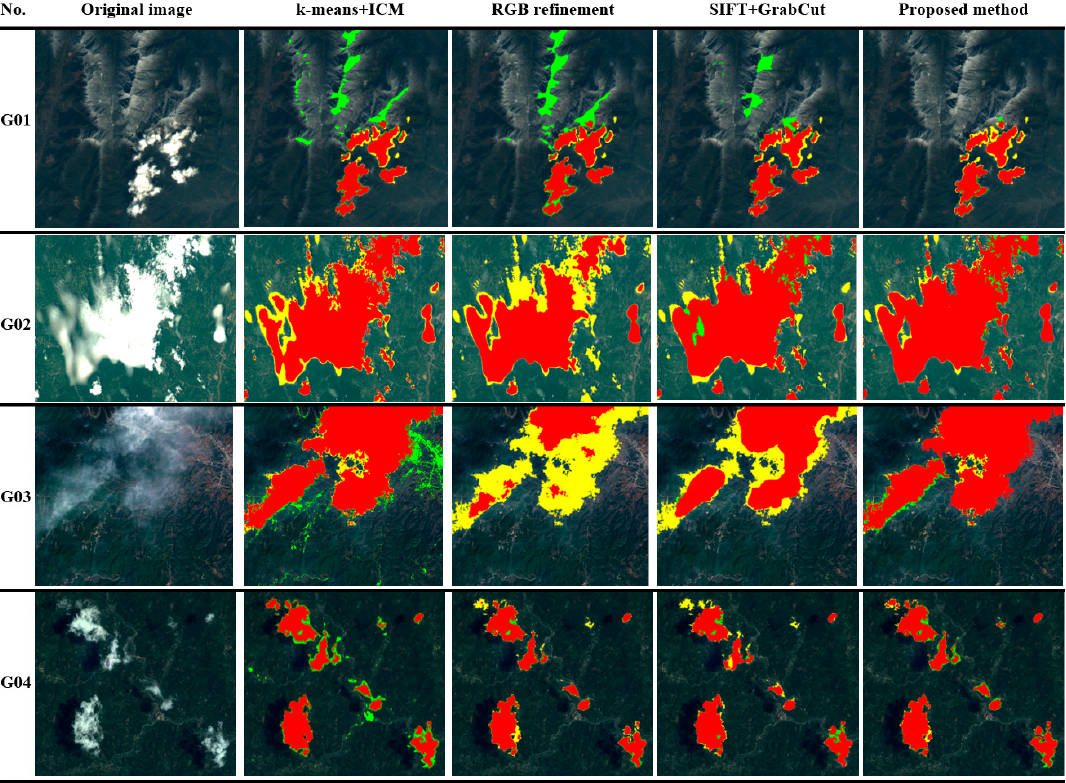
Figure 16. Results of comparison with automatic cloud detection algorithms and comparison of visually extracted clouds with those obtained by automatic detection algorithms (Red denotes the extracted true cloud regions, yellow denotes the missed true cloud regions, green denote the non-cloud regions misjudged as cloud regions).